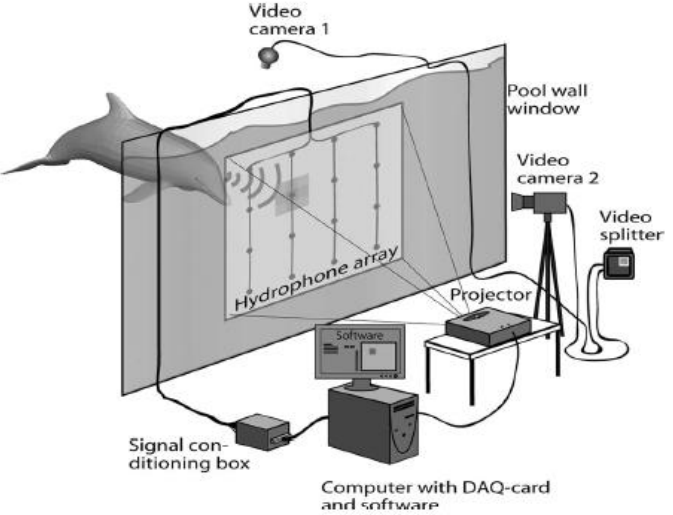
Figure 6. ELVIS – Underwater acoustic touchscreen for tracking sonar beam used at Kohlmarden Park in Sweden. Reprinted with permission from AIP Publishing LLC: JASA through